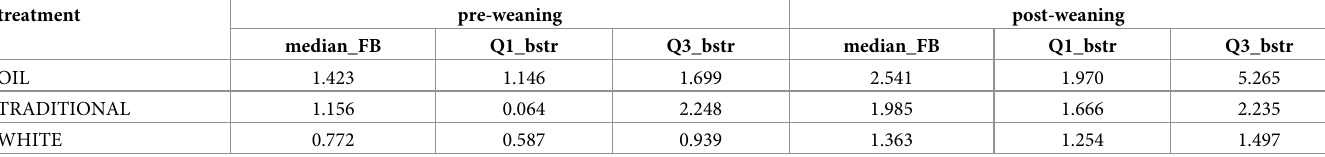
Table 3. F:B ratio between treatments and timepoints. Q1_bstr and Q3_bstr are the first and third quartiles from the bootstrapping distribution of the F:B ratio (n = 1000).